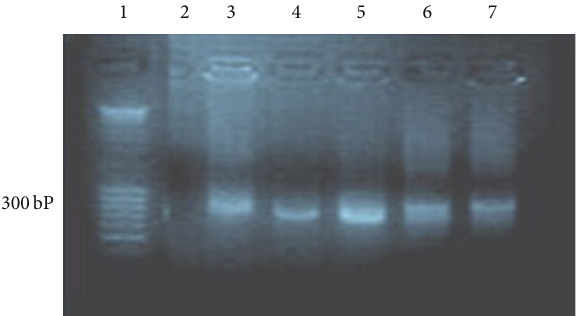
Figure 2: Agarose gel electrophoresis PCR products of the isolated DNA of the parasites after treatment with Ximenia americana extract. Lane 1, DNA marker 100bp plus; Lane 2, water (negative control); Lane 3, untreated group; Lane 4, treatment with 25 mg/mL fraction IV portion; Lane 5, treatment with 3.5 mg/kg body weight diminazene aceturate group; Lane 6, trypanosome genome (Bre- men); Lane 7, trypanosome genome (Vom) (positive control).